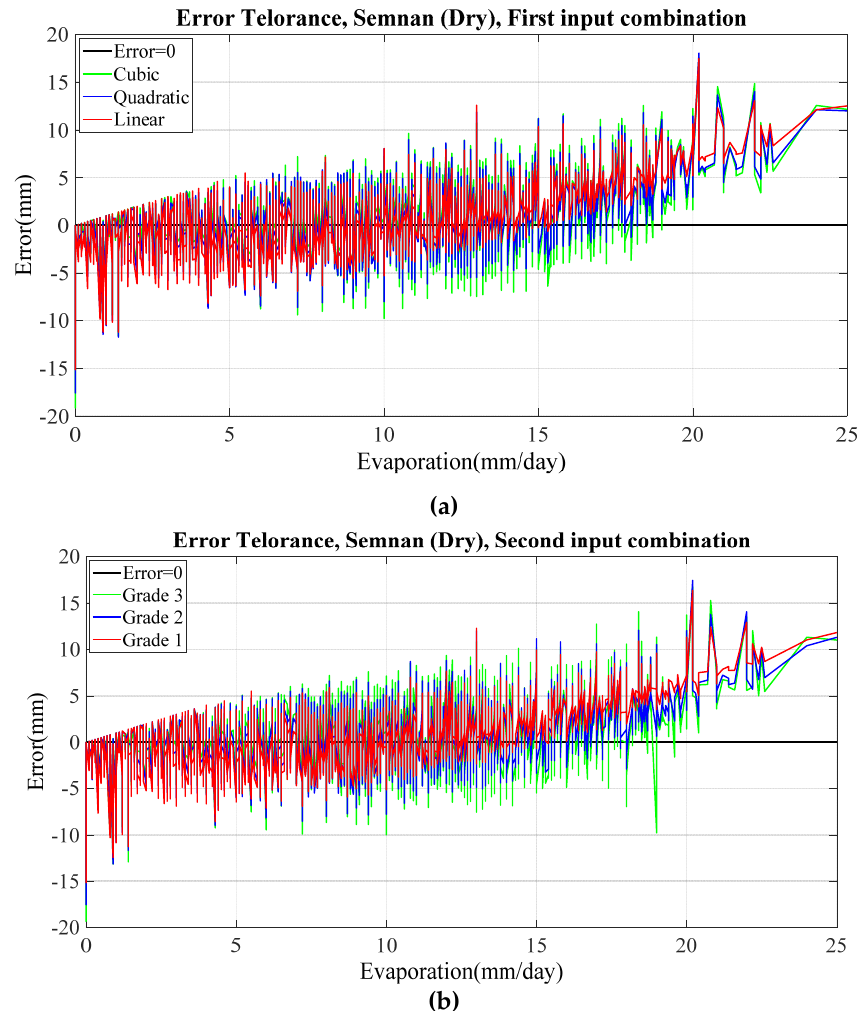
Figure 5. Error tolerance of linear, quadratic, and cubic experimental relationships (shown in red, blue, and green, respectively) in the simulation of pan evaporation at Semnan station (dry conditions) for ( a ) the two-parameter input combination and ( b ) the four-parameter input combination (see Table 1 for input combinations) .